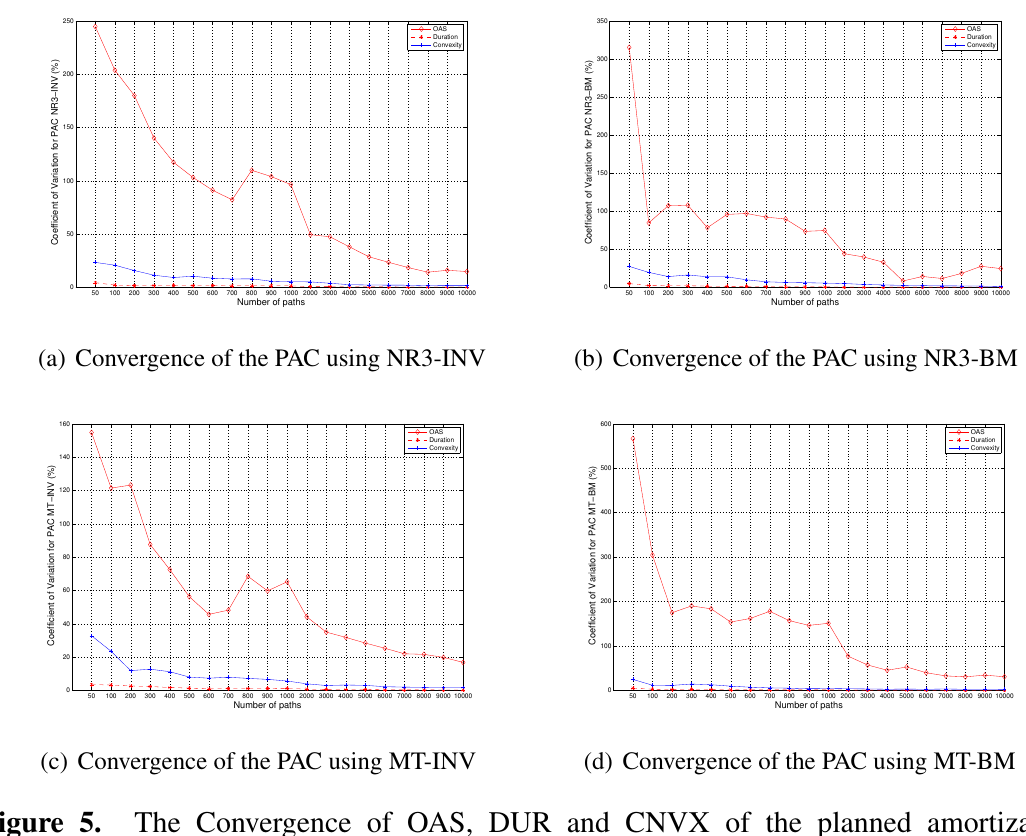
The Convergence of OAS, DUR and CNVX of the planned amortization class (PAC) using different random number generator combinations, NR3-INV, NR3-BM, MT-INV and MT-BM. The vertical axis is for the coefficient of variation (%). The horizontal axis is the number of